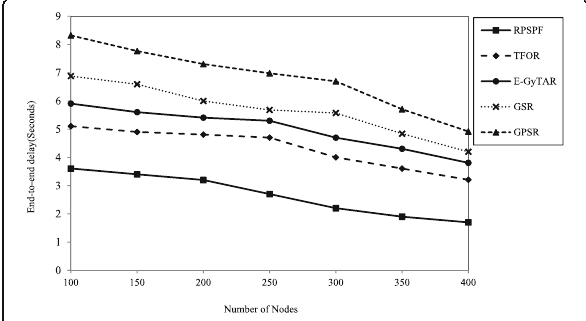
Fig. 8 End-to-end delay as a function of the number of nodes (@5 packets/s). RPSPF represents Reliable Path Selection and Packet Forwarding Routing Protocol which is proposed approach and is represented by a solid line with a square. TFOR is traffic flow- oriented routing protocol and is represented by a dashed line having rhombus. E-GyTAR is Enhanced Greedy Traffic Aware Routing protocol and is represented by a solid line with circle. GSR is geographic source routing protocol and is presented by a dotted line having a cross. GPSR is Greedy Perimeter Stateless Routing Protocol and is presented by a dashed line having a triangle